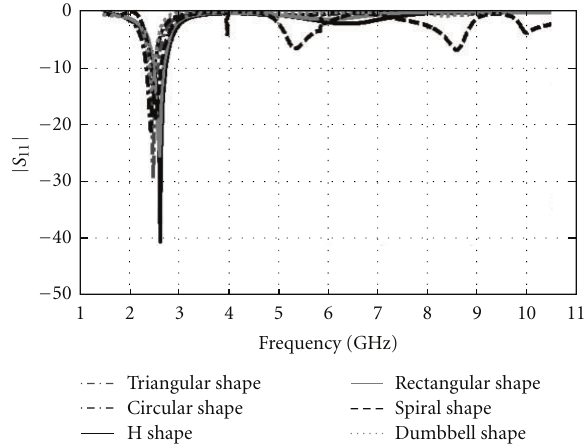
Figure 3: Simulated reflection coe ffi cients of HSA with di ff erent kinds of DGS. The position and etched square area of every DGS are identical.